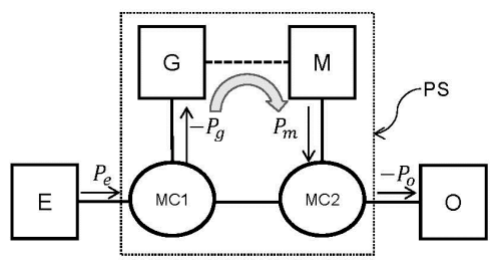
Figure 2. Power flow through the power split e-CVT.